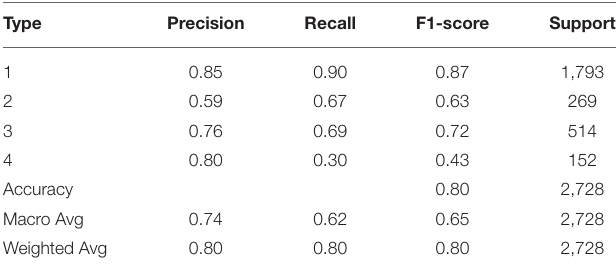
TABLE 3 | Assessment of machine learning upon Weibo blogs. TABLE 4 | Description of happiness classification upon Weibo